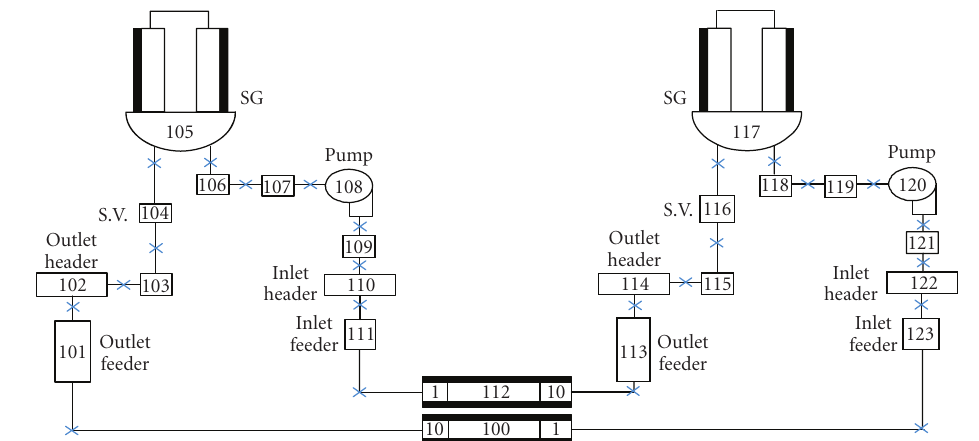
Figure 3: 700 MWe PHWR loop-1 nodalisation.